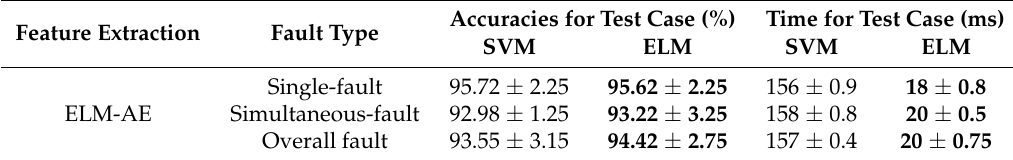
Table 6. Evaluation of methods using ELM or SVM with ELM based autoencoder (Note: Dimension reduction from 20,480 to